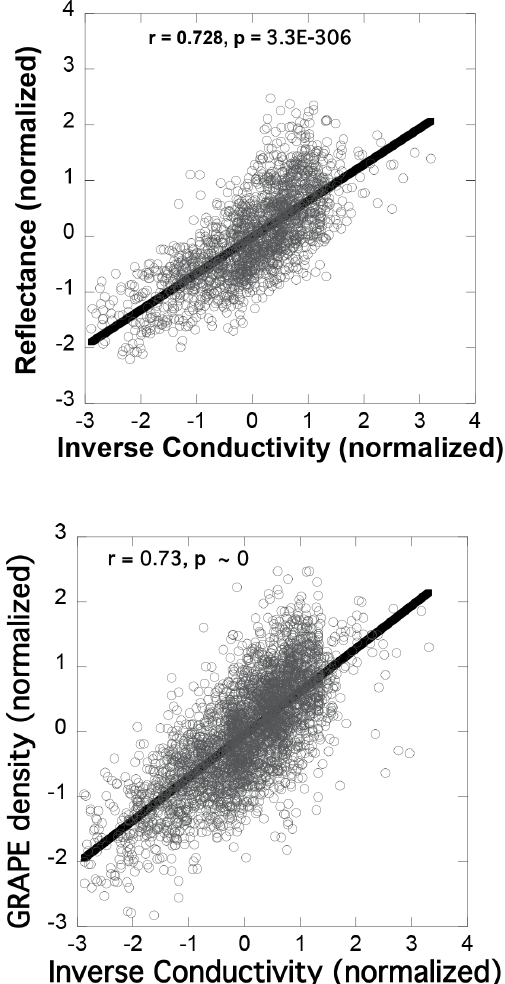
Figure 2. Correlations of the inverse of borehole log conductivity (detrended and normalized) to GRAPE density (detrended and nor- malized) and to color reflectance (channel 1, detrended and normal- ized) over the depth interval 85–170mb.s.f. (95–181mc.d.); Hole 846B. Note that the inverse of conductivity is plotted. Both corre- lations ( N = 1853, 3388) are highly significant. Correlations of the same variables from holes 846C and 846D were very similar.